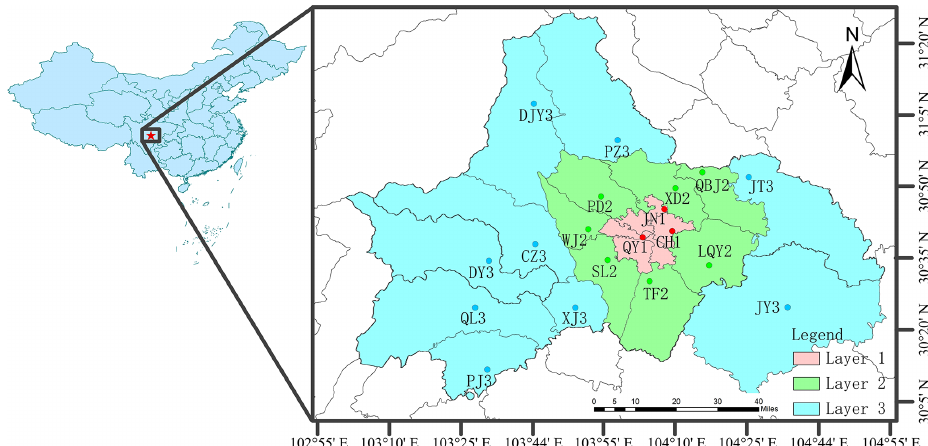
Figure 1. The locations of 19 sampling sites in Chengdu from 2015 to 2019.